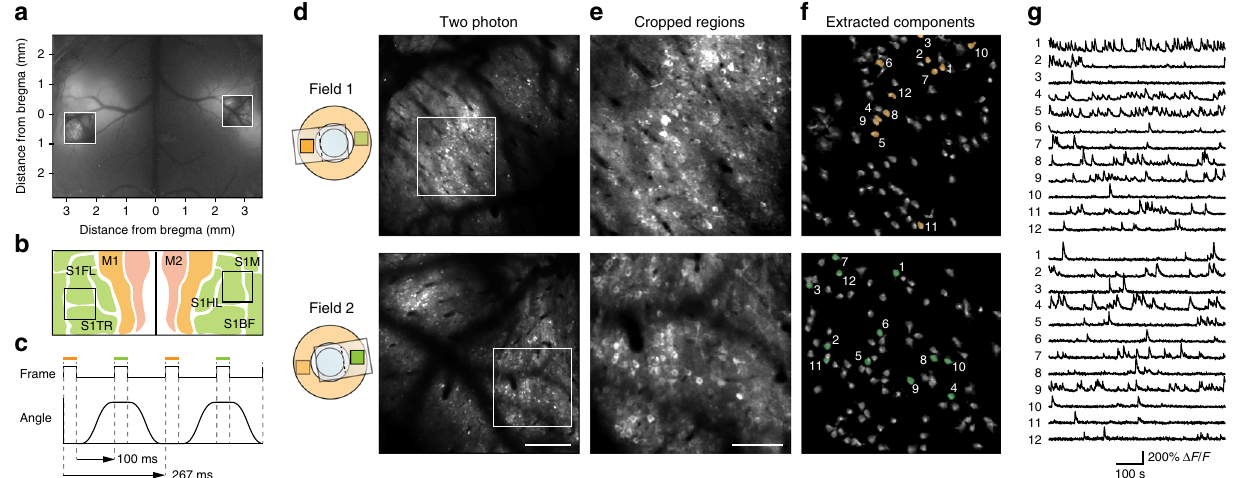
Fig. 4 In vivo super-wide- fi eld two-photon calcium imaging of bilateral S1. a An epi fl uorescence image of R-CaMP1.07-expressing neocortex. White squares indicate imaging fi elds in d . b A dorsal cortex map (modi fi ed from the Allen Brain Atlas 70 ) and imaging fi elds in d . M1 primary motor area, M2 secondary motor area, S1M, primary somatosensory area (mouth), S1HL primary somatosensory area (hind limb), S1TR primary somatosensory area (trunk), S1BF primary somatosensory area (barrel fi eld). c Timing chart of the dual- fi eld imaging. Each fi eld (orange, left S1; green, right S1) was imaged after changing the angle of the device. Dotted lines indicate the start and end timing of each frame acquisition. d Averaged two-photon images of layer 2/3 neuronal somata in the left S1 (top) and right S1 (bottom) in an awake mouse. The depth of the images was 150 μ m from the cortical surface. Scale bar, 200 µ m. e Enlarged views of the corresponding white squares in d . Scale bar, 100 µ m. f Spatial components extracted by the constrained non-negative matrix factorization algorithm. g Representative Δ F/F traces of the 12 components numbered in f for each fi eld. The raw fl uorescence signals are shown to demonstrate the original imaging quality (see Methods for